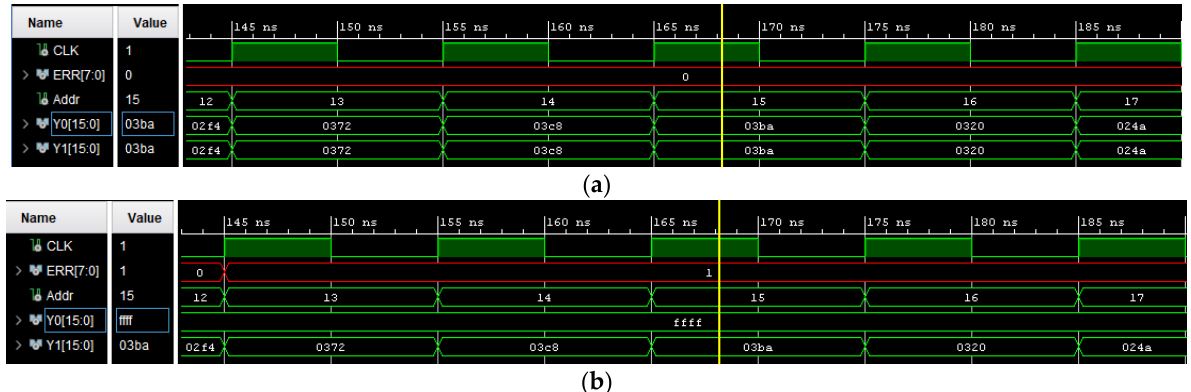
Figure 10. ( a ) Simulation without an SEU. ( b ) Simulation with an